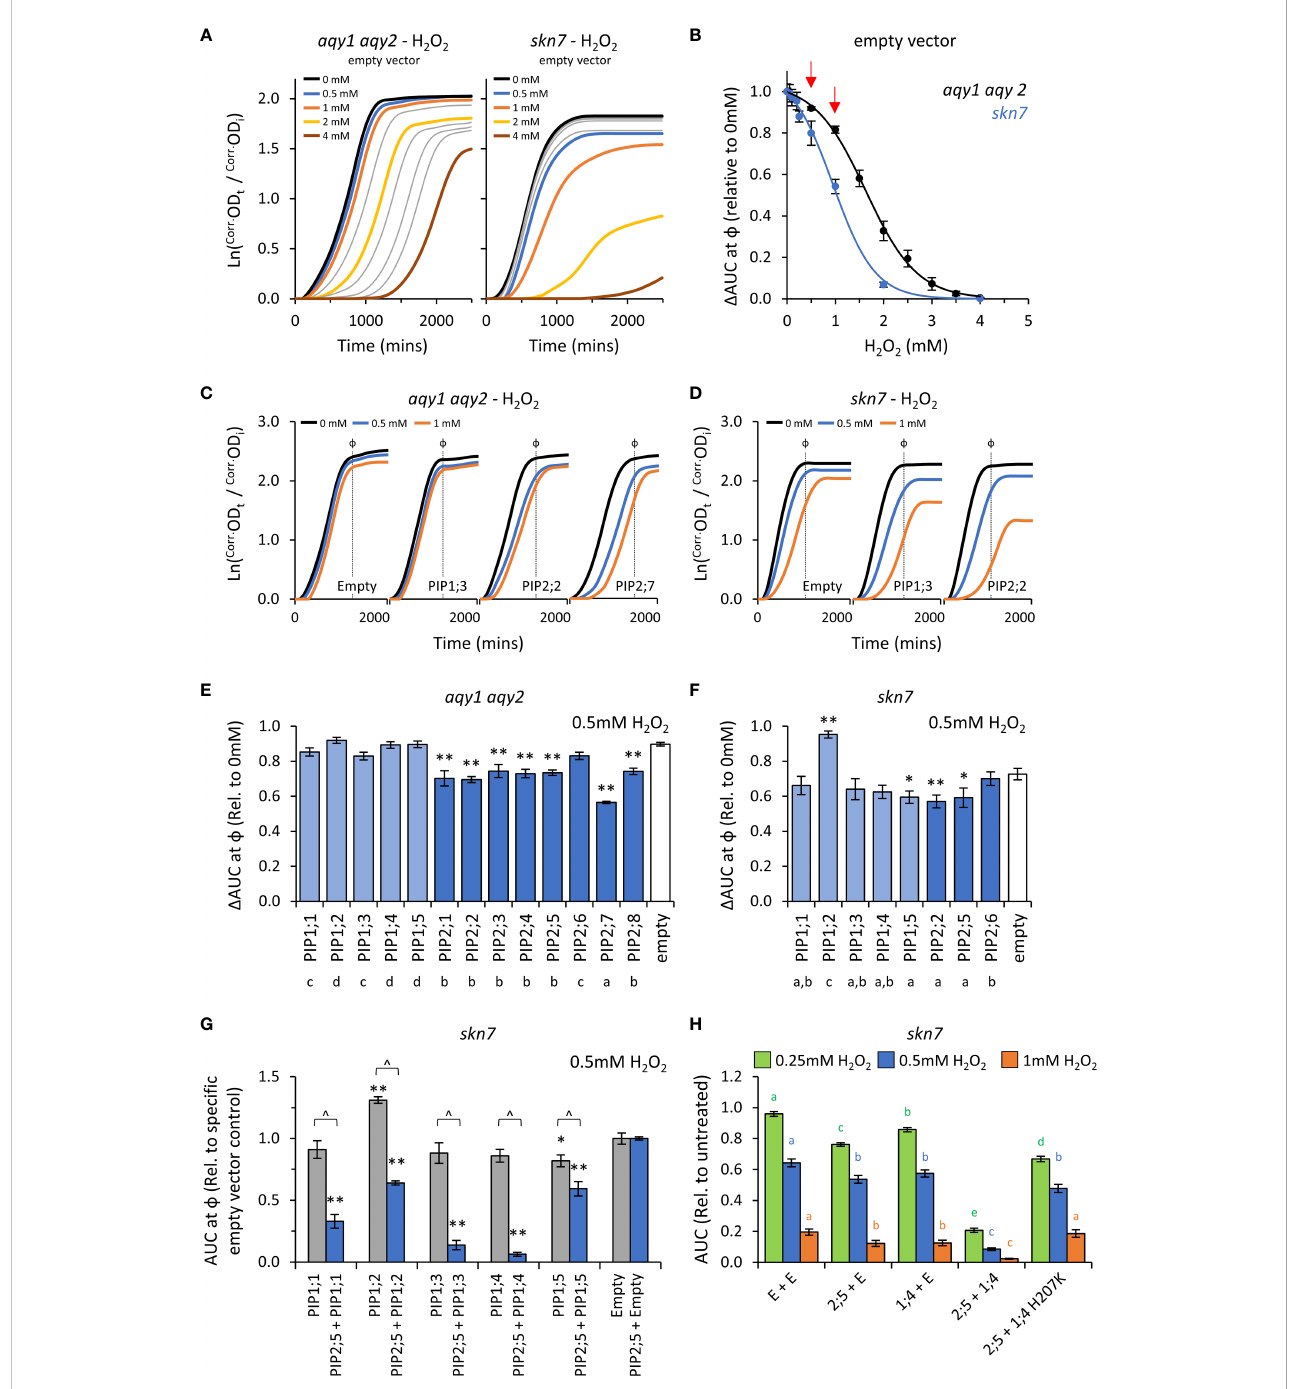
FIGURE 5 H 2 O 2 permeability assays. (A) , Comparison of growth curves of two yeast strains, aqy1 aqy2 or skn7 , exposed to increasing H 2 O 2 concentrations. Concentrations related to the colored lines are provided in the graph. Grey lines represent intermediate concentrations of 1.5, 2.5, 3.0, 3.5 mM, respectively for aqy1 aqy2 , and 0.05, 0.1, 0.2, and 0.25 mM, respectively for skn7 . (B) , Dose response curves showing relative AUC as a function of H 2 O 2 concentration for each strain. s kn7 yeast are more sensitive to H 2 O 2 treatment than aqy1 aqy2 yeast. Red arrows indicate H 2 O 2 concentrations chosen for testing yeast expressing AtPIP . (C) , Example growth curves of aqy1 aqy2 yeast expressing different AtPIP genes exposed to various H 2 O 2 concentrations. (D) , Example growth curves of skn7 yeast expressing different AtPIP genes exposed to various H 2 O 2 concentrations. (E) , Relative AUC for aqy1 aqy2 yeast expressing each AtPIP gene exposed to 0.5mM H 2 O 2 . (F) , Relative AUC for skn7 yeast expressing AtPIP1 and selected benchmark AtPIP2 genes exposed to 0.5mM H 2 O 2 . (G) , Relative AUC for skn7 yeast exposed to 0.5mM H 2 O 2 expressing AtPIP1 singly (grey) or together with AtPIP2;5 (blue). Each set is standardized to their respective empty vector control. (H) , Relative AUC for skn7 yeast expressing various combinations of AtPIP genes at 0.25, 0.5 and 1mM H 2 O 2 . All error bars are SEM. For (E, F) , asterisks indicate statistical difference from empty vector control, ANOVA with Fishers LSD test (* P < 0.05; ** P < 0.01); letters denote different statistical rankings across both 0.5 and 1mM H 2 O 2 , ANOVA with Tukey ’ s test ( P < 0.05). For (G) , asterisks indicate statistical difference from empty vector control, ANOVA with Fishers LSD test (* P < 0.05; ** P < 0.01); chevrons (^) indicate statistical difference between single vs. co-expression (Student ’ s t test P < 0.01). For (H) , color coded letters denote different statistical groupings within [H 2 O 2 ] treatments, ANOVA with Fishers LSD test. N = 4 bio reps for (B) N = 6 (2 biological reps x 3 experimental runs) for (E) N = 8 across 4 experimental runs for (F) For G, N = 12 across 6 experimental runs for single expressed AtPIPs and N = 6 across 3 experimental runs for co-expressed lines. N = 16 across 4 experimental runs for